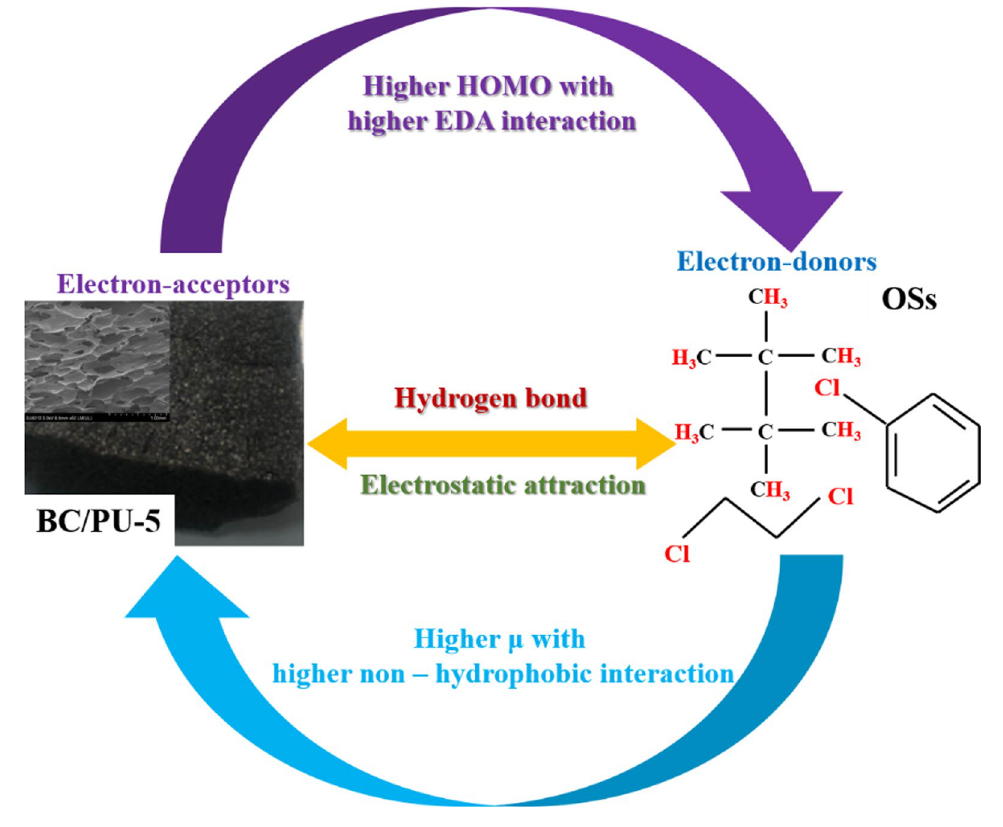
Fig. 10 Proposed adsorption mechanism of OSs on BC/PU-5